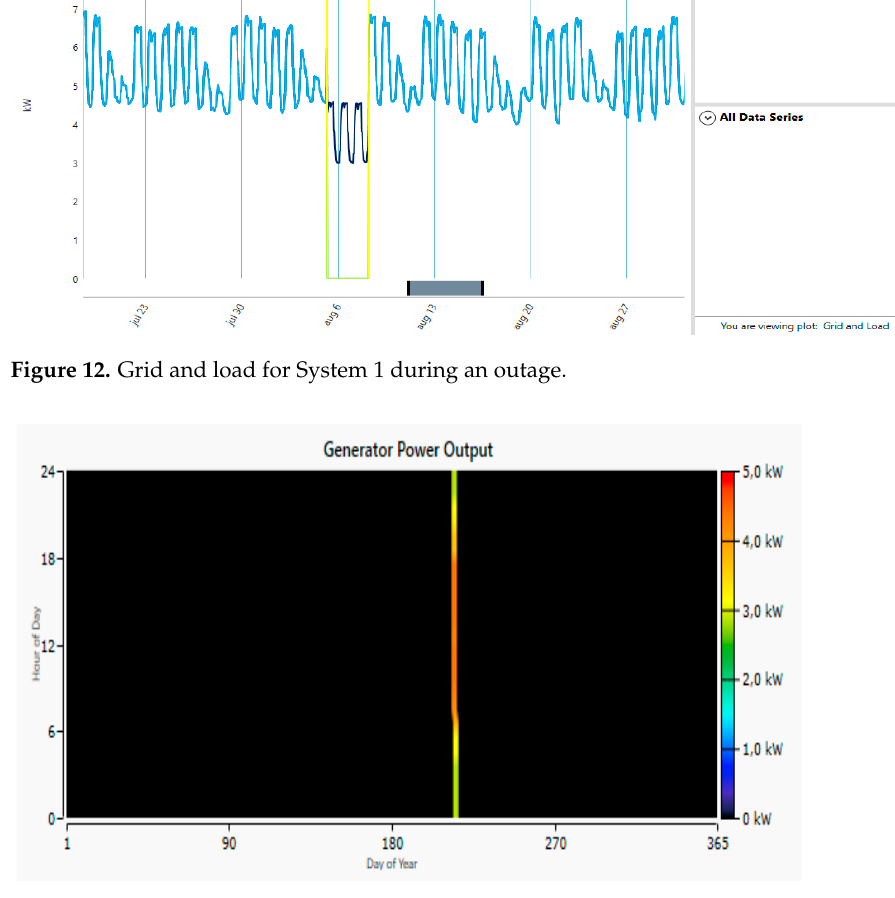
Figure 14. Monthly electric production for System 1. Table 6. Parameters for system 1. Specification